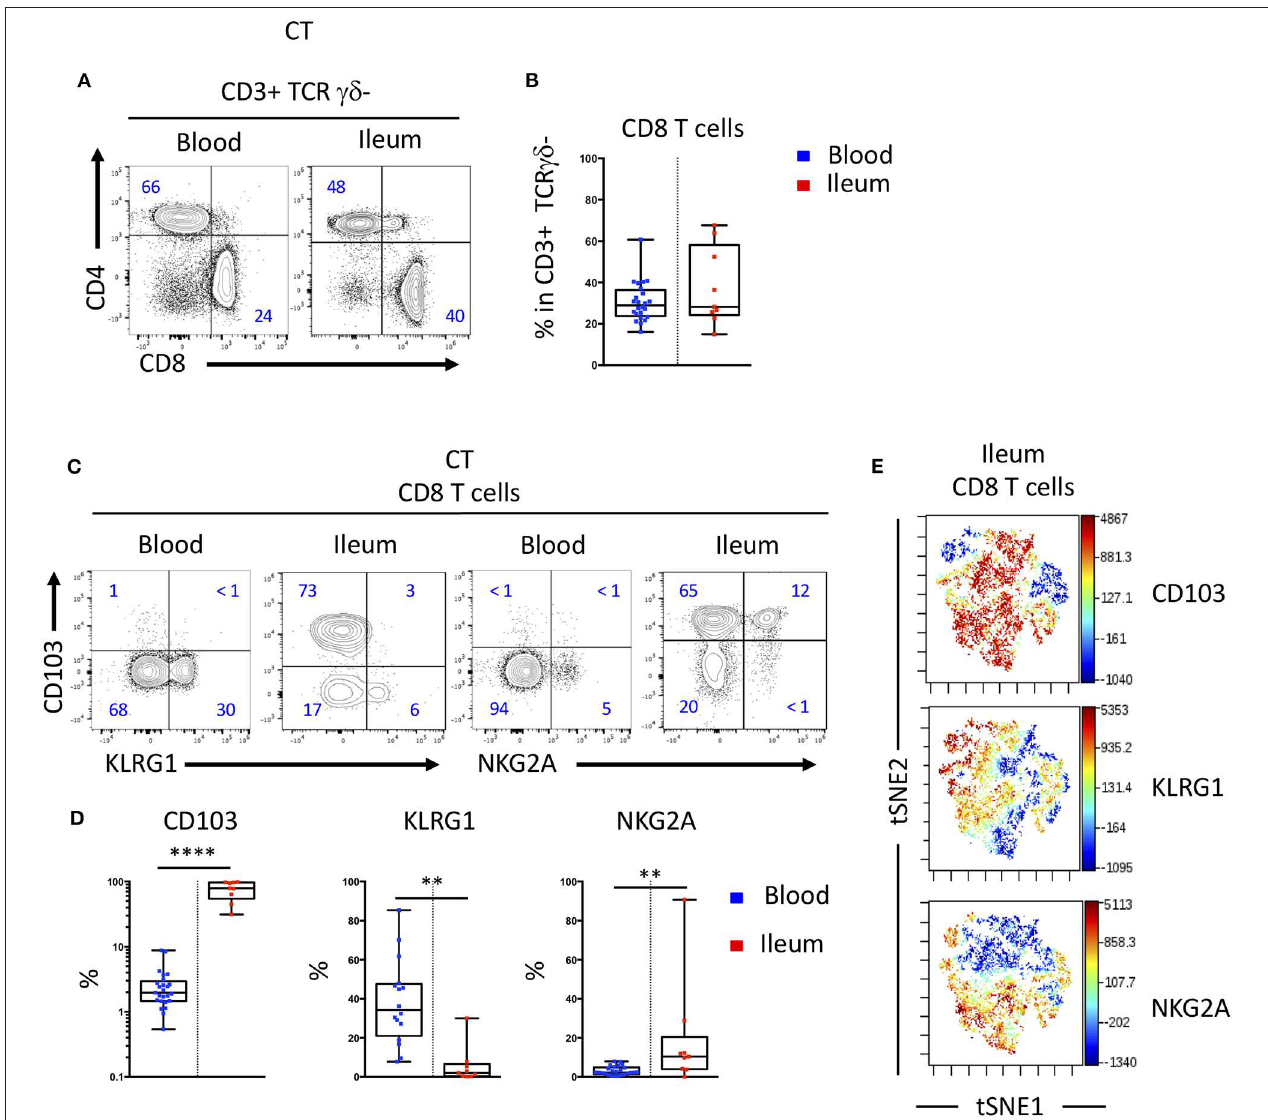
FIGURE 1 | CD103 and KLRG1 expressions on CD8 T cells are mutually exclusive in blood and intestinal mucosa. (A) Representative staining and (B) proportions of CD4 and CD8T cell subsets in blood and ileal mucosa of control individual (CT) ( n = 25 and n = 10 for blood and ileum, respectively; boxes represent median and range). (C) Representative staining and (D) quantification of CD103, KLRG1 and NKG2A expression on CD8T cells in blood and ileal mucosa of control individuals (CT) ( n = 25 and n = 10 for blood and ileum, respectively; boxes represent median and range; unpaired t -test: ** p < 0.001, **** p < 0.00001). (E) tSNE analysis of CD103, KLRG1 and NKG2A expression on ileal mucosal CD8T